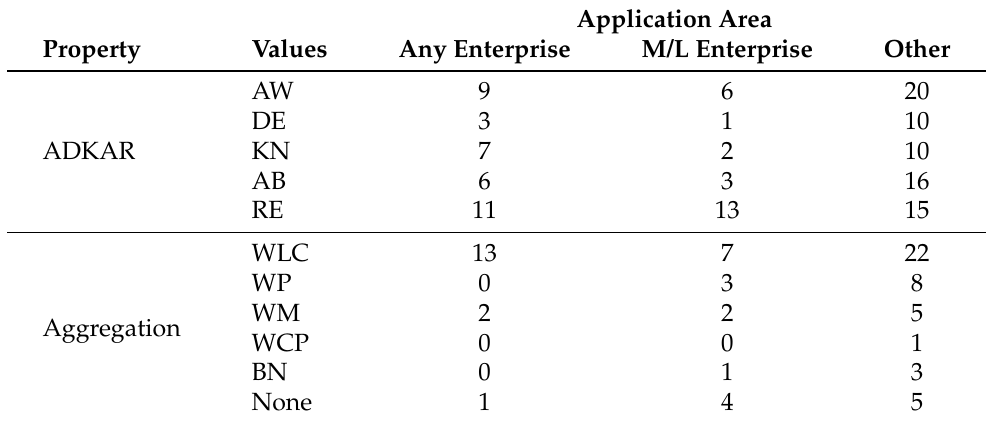
Table 9. ADKAR and aggregation strategy frequencies of enterprise research and other